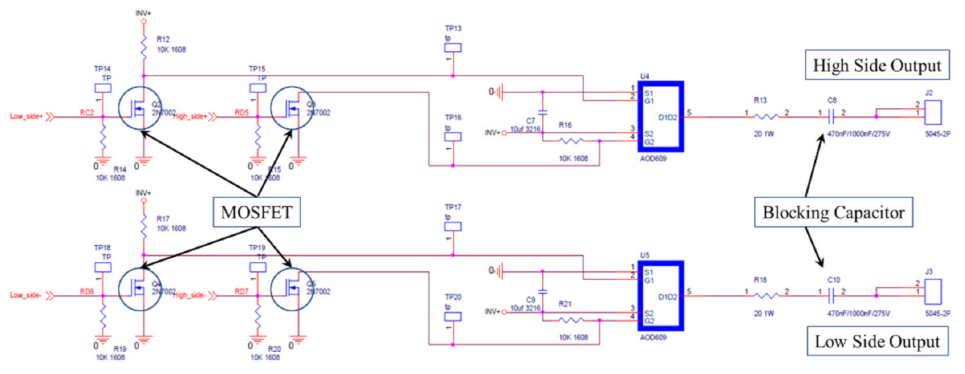
Figure 21. Frequency generator circuit for the